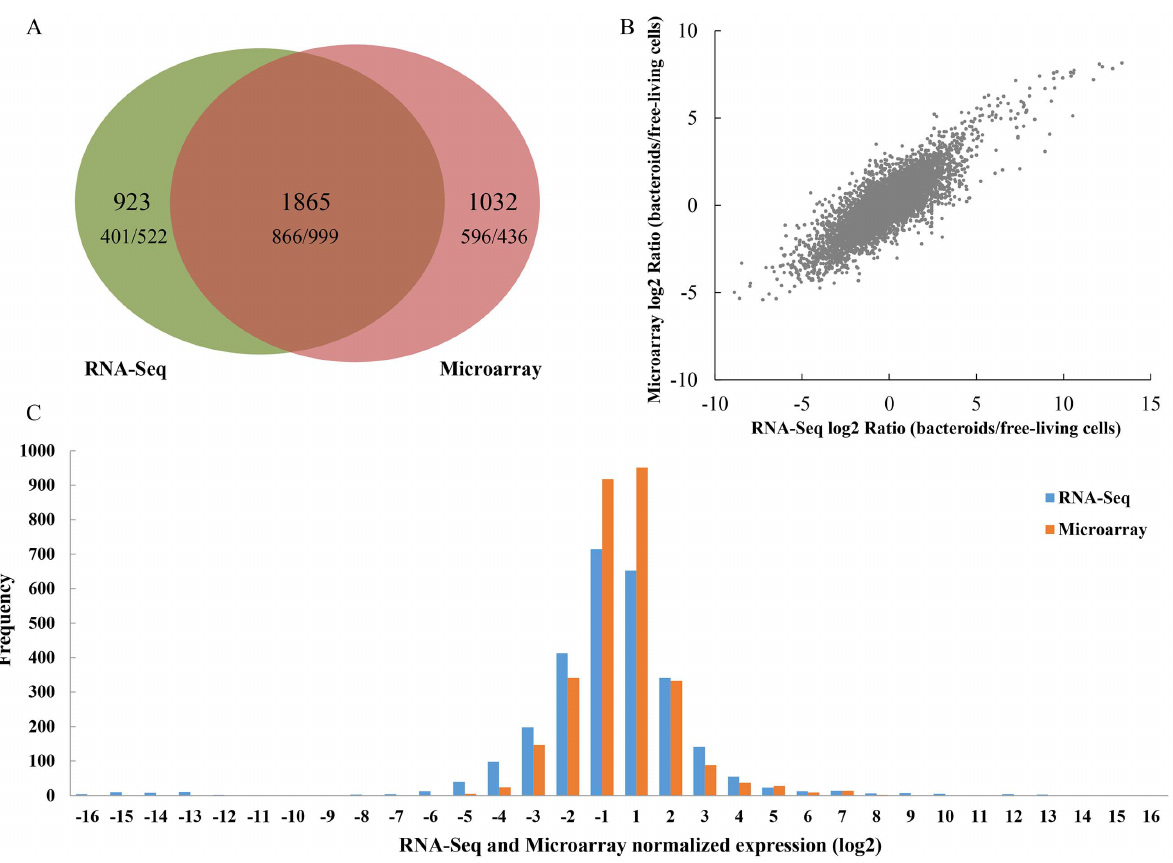
Figure 1. Schematic view of data from RNA-Seq and Microarrays. A: Venn diagram summarizing the overlap between differentially expressed genes from RNA-Seq ( left circle) and Microarrays ( right circle). The number of genes called by both methods is indicated by the overlap between the two circles. It also contains the numbers of up/down-regulated genes for each set in the Venn-Diagram. B: Comparison and correlations analyses of differentially expressed genes in RNA-Seq and Microarrays. The plot shows log2 ratios (bacteroids/free-living cells) of expressed genes in RNA-Seq ( x axis) and Microarrays ( y axis) (7043 genes in total). Pearson’s correlation coefficient (r) is indicated for each comparison. C: Distribution of differentially expressed genes detected by RNA-Seq and Microarrays. Genes detected by RNA-Seq are shown with blue bars. Genes detected by Microarrays are shown with orange bars.